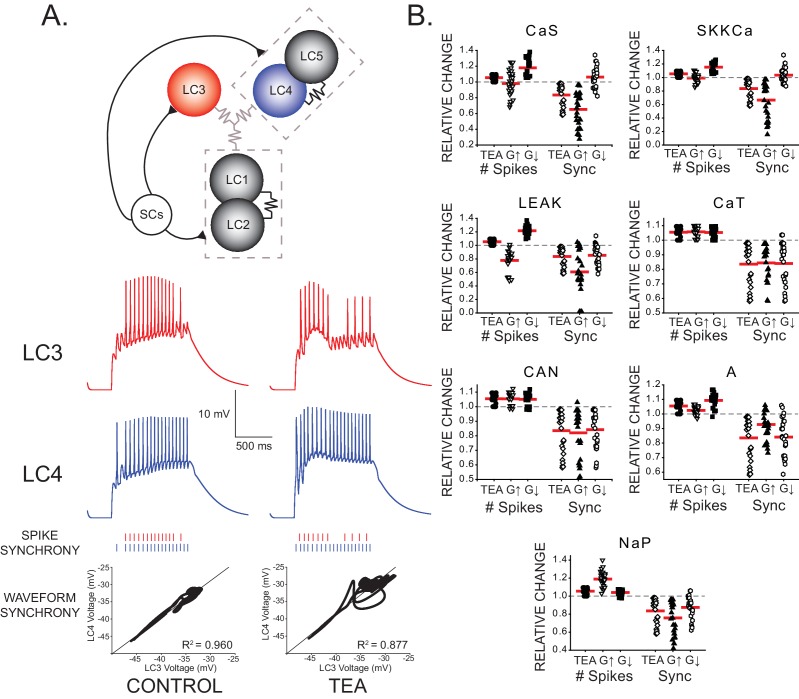
Effects of increasing and decreasing individual ionic conductances on excitability and synchrony in model CG networks.(A) Schematic representation of model network organization and connectivity. Five large cell (LC) motor neurons are innervated via excitatory synapses from a common small cell pacemaker input (SCs). LC model neurons consist of two compartments - soma and axon - of which only the somata are pictured. Somata contain 9 conductances: GCaS, GCaT, GLEAK, GCAN, GA, GBKKCa, GSKKCa, GKd, and GNaP. Paired LCs (1+2, 4+5) have stronger local coupling (black resistor symbols), and all 5 LCs are reciprocally electrically coupled via weaker gap junctions (gray resistor symbols). An example of LC3 and LC4 model output within a network burst activity is shown in the red and blue traces under both control and TEA (90% reduction in both GKd and GBKKCa) conditions. Graphical representations of spike synchrony (raster plots) and waveform synchrony (scatterplots; as in Figure 2) are shown for the model neurons, demonstrating that both measures reflect the loss of LC synchrony as a result of TEA. (B) Measurements of both output variables (# of spikes and spike synchrony) were made under three model conditions: control, TEA, and TEA + either a 2x increase (G↑) or 2x decrease (G↓) in a given conductance. N = 27 distinct model networks. All output measurements are normalized to their initial (control) conditions. Red lines represent the mean for a given group. Dashed line represents the 1.0 value (baseline) for a given measure. Compensatory responses that restore excitability and synchrony will tend to move the mean towards baseline.